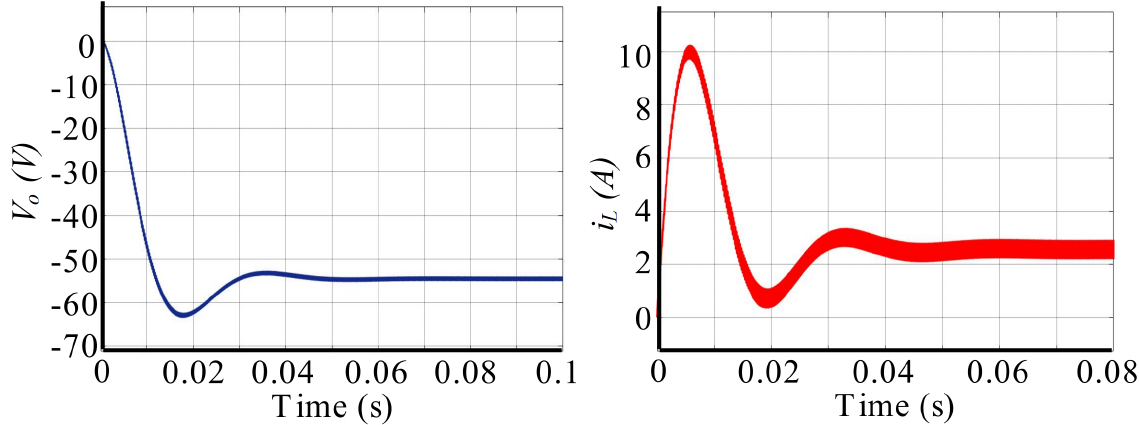
Figure 11. Graph of the S 3 parameter set ICCV in continuous time through (20)–(23) and knowledge of the ICCV at the beginning of each switching period.